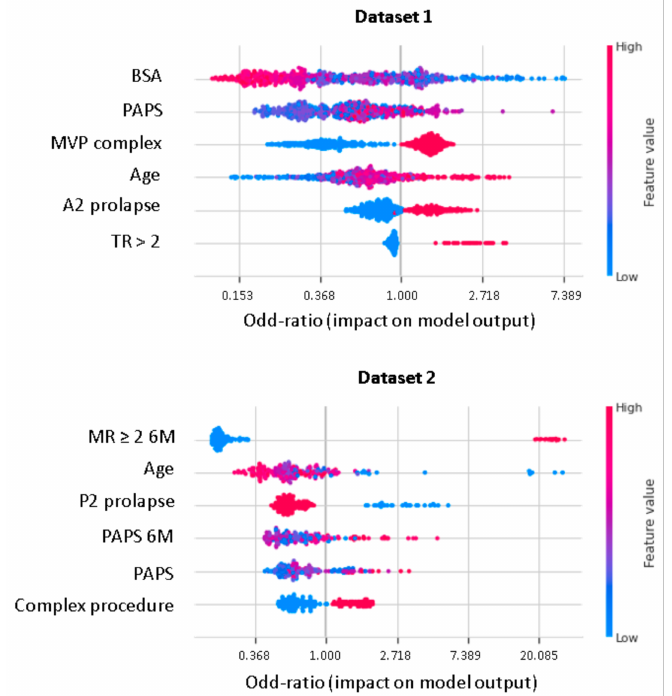
Figure 4. Shapley additive explanations value plot for DS1 and DS2. The horizontal axis shows whether the effect of the feature is associated with a higher or lower prediction, while the color indi- cates whether the value of the feature is high (red) or low (blue) for a given observation. MVP, mitral valve prolapse; BSA, body surface area; TR, tricuspid regurgitation > 2; PAPS, systolic pulmonary artery pressure; MR, mitral valve regurgitation; 6M, six